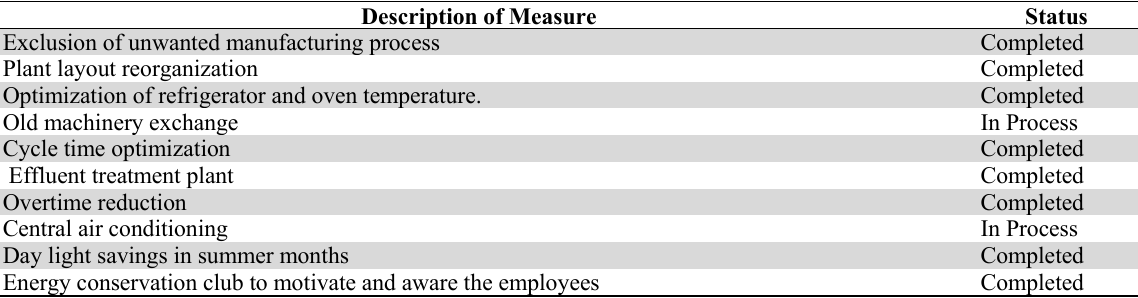
Description and Status of Various Measures for Energy Conservation Description of